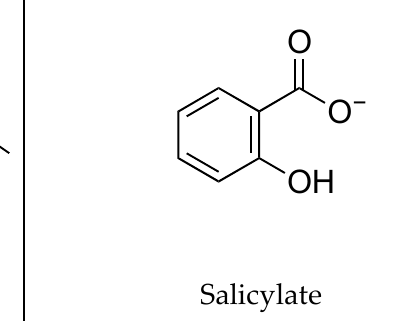
Figure 12. Counter ions PHY and Salicylate.